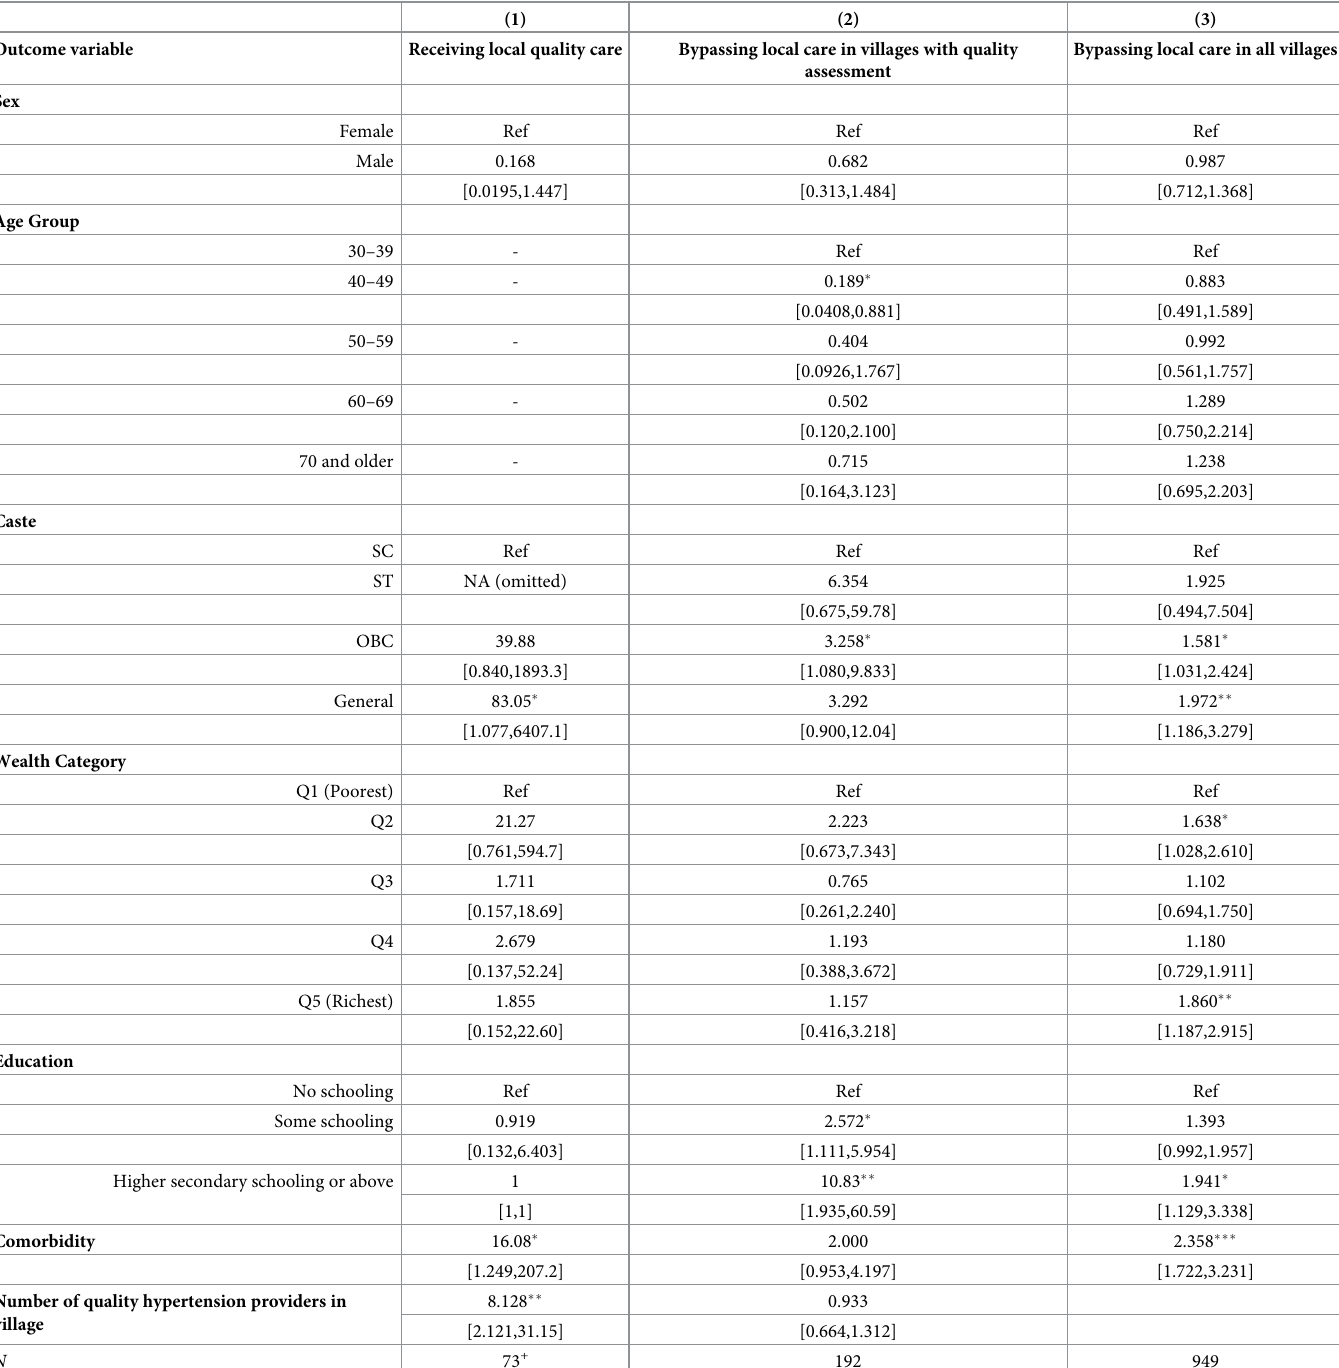
Table 4. Determinants of receiving quality care from local providers and bypassing among hypertensive adults in Bihar. (1) (2)